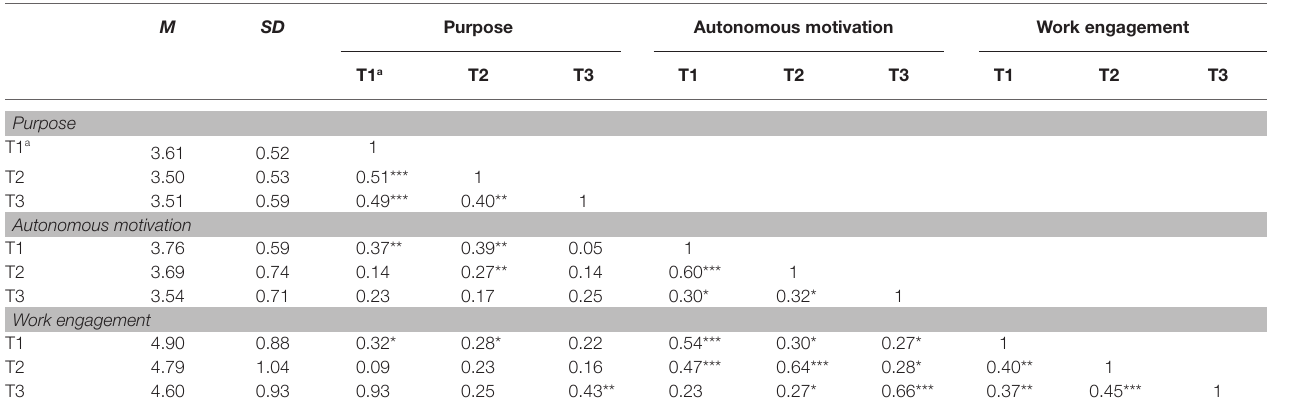
TABLE 4 | The means ( M ), standard deviations ( SD ), and intercorrelations ( r ). M SD Purpose Autonomous motivation Work engagement